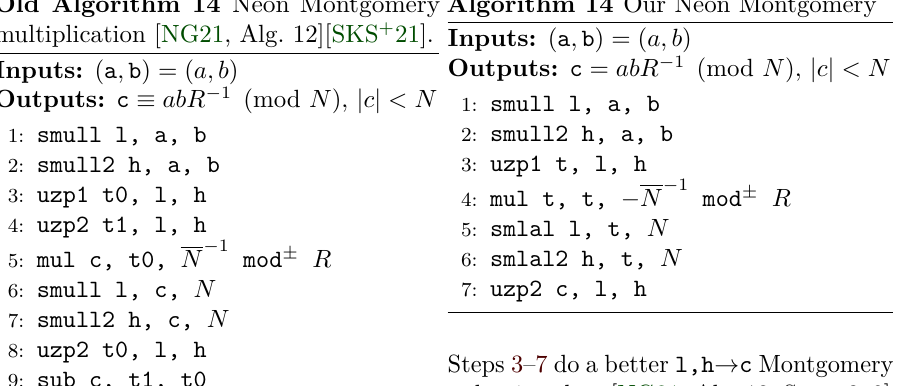
Algorithm 14 Our Neon